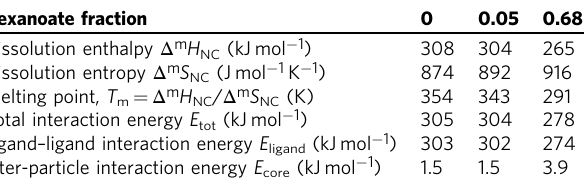
Table 1 The thermodynamic parameters of nanocrystal- ligands complexes obtained via light scattering (top panel) and via NMR-based calculations (bottom panel)